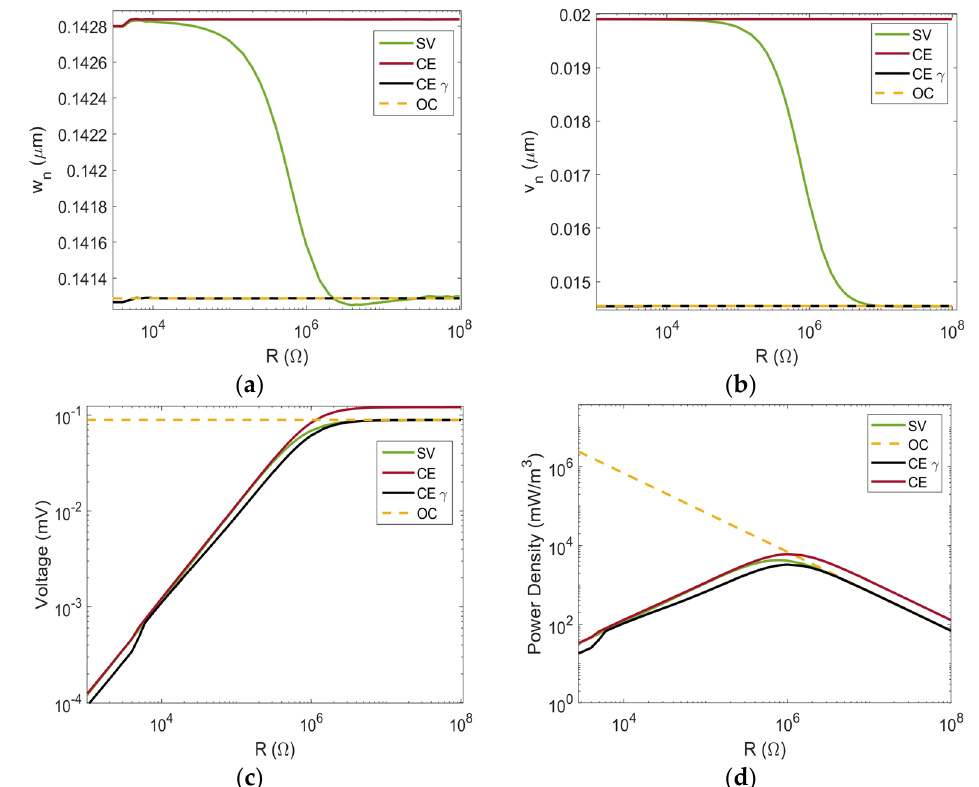
Figure 11. Electrical load resistance effects for various models under consideration: ( a ) driving mode, ( b ) sensing mode, ( c ) generated voltage, and ( d ) power density when 𝑉 (cid:3005)(cid:3004) = 1𝑉 , 𝑉 (cid:3002)(cid:3004) = 0.1 V, ( b ) sensing mode, ( c ) generated voltage, and ( d ) power density when V DC = 1 V, V AC = 0.1 V, Ω = 80 rad Ω = 80 (cid:3045)(cid:3028)(cid:3031) , 𝜇 = 0.01 . , µ = (cid:3046) s